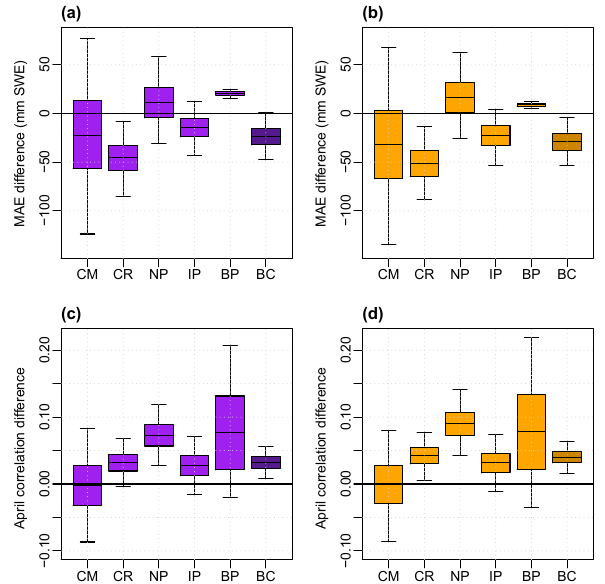
Figure 9. Box plots of bootstrap station differences in MAEs and April correlations showing quartiles and 95% confidence inter- vals for ANNs of six products, ANN6 (purple), and of the best three products, ANN3 (orange), with respect to VIC. Bootstrap difference distributions are shown for (a) ANN6 − VIC MAEs, (b) ANN3 − VIC MAEs, (c) ANN6 − VIC April correlations, and (d) ANN3 − VIC April correlations. Notation for the physiographic regions follows Fig.